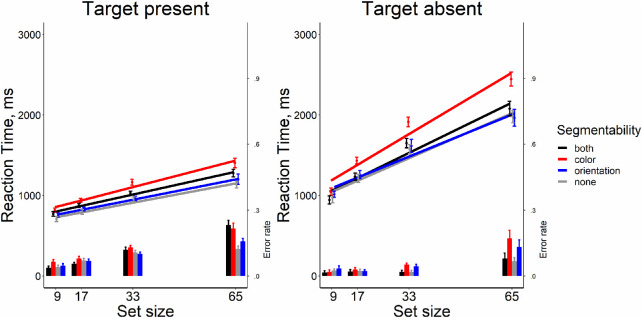
Reaction time and error rate as a function of set size and segmentability in Experiment 5. Error bars denote the SEM, with between-subject variance removed in accordance with the Cousineau (2005) method.